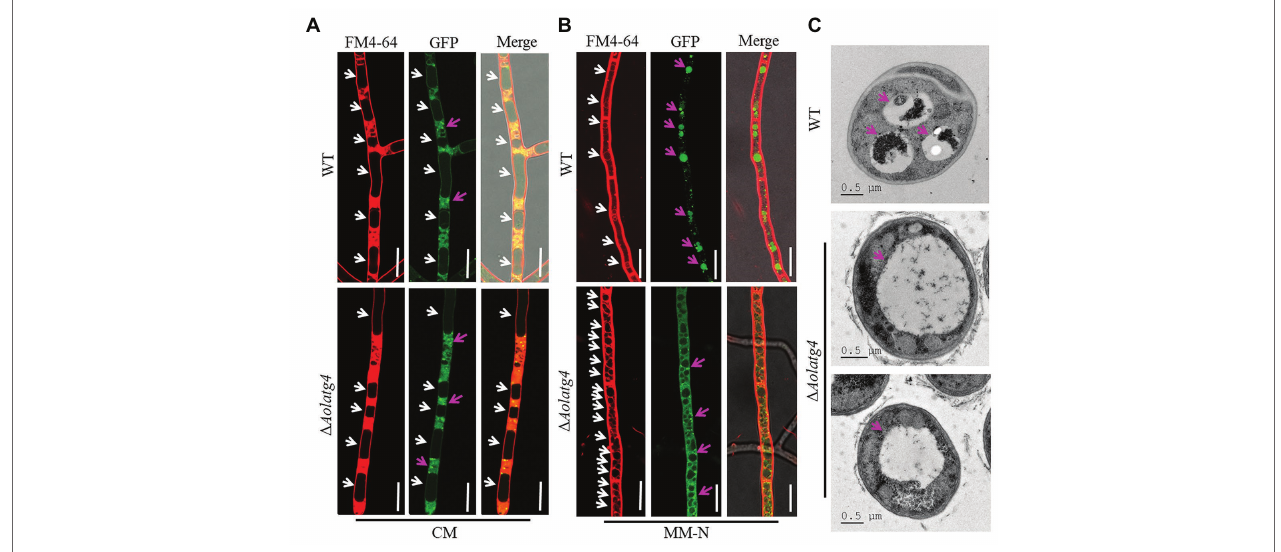
FIGURE 4 | Observation of autophagosomes in the hyphal vacuoles of the WT and ∆ Aolatg4 mutants. (A) Observation of the WT and ∆ Aolatg4 mutants expressing GFP-Atg8; the strains were cultivated in liquid CM medium at 28 ° C for 48 h. (B) Observation of the WT and ∆ Aolatg4 mutants expressing GFP-Atg8; the strains were grown in liquid CM medium at 28 ° C for 24 h, and then transferred to liquid MM-N medium for 6 h. The vacuoles were stained by FM4-64 and examined by fluorescence microscopy. White arrow: vacuoles; red arrow: autophagosomes. Scale bars = 10 μ m. (C) The vacuoles of hyphal cells were observed using transmission electron microscopy. Arrows indicate the vacuole. Scale bars = 0.5 μ m.